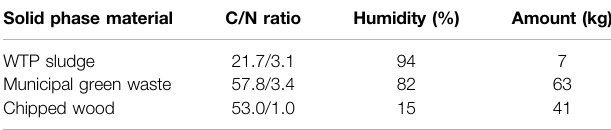
TABLE 1 | Formulation of the compost solid phase.